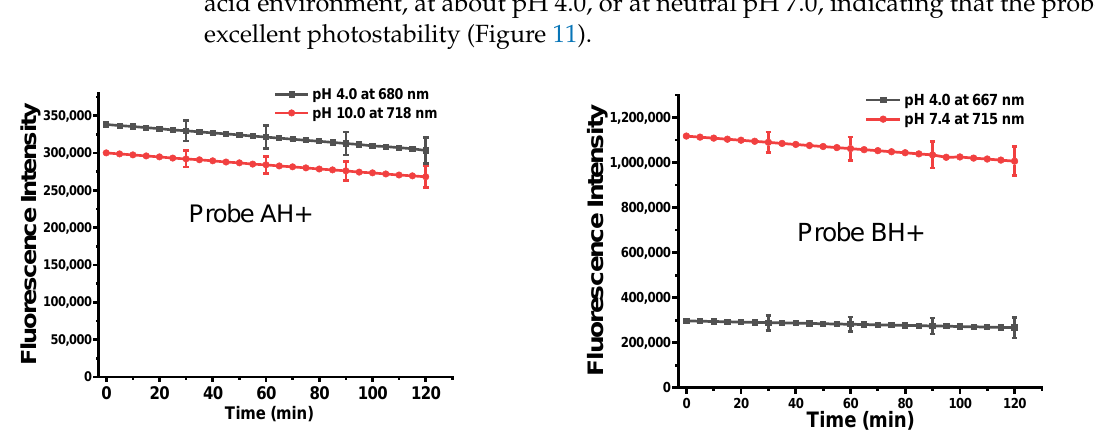
Figure 10. Fluorescence intensities of 10 µ M probes AH + ( A ) and probe BH + ( B ) in the absence and presence of different amino acids (200 µ M) in pH 7.4 buffers under excitation at 635 nm, respectively.